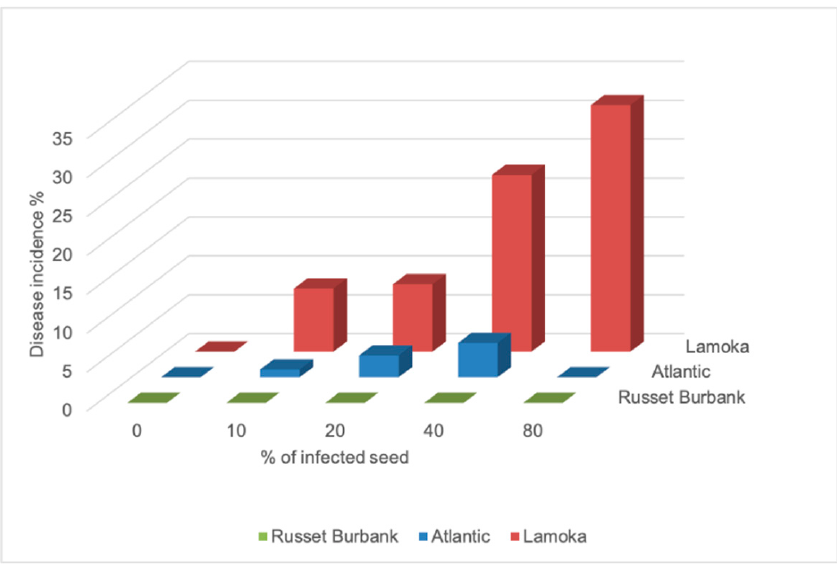
Figure 2. Disease incidence affected by infection of potato “Lamoka”, “Russet Burbank”, and “Atlantic” seed pieces inoc- ulated with Dickeya dianthicola in 2019.